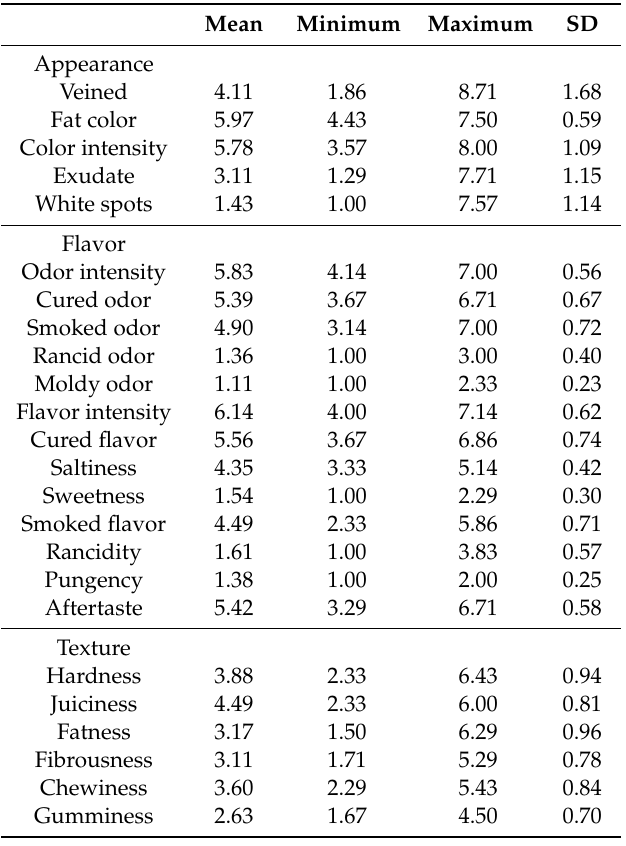
Table 1. Mean, minimum, maximum and standard deviation for 50 samples of